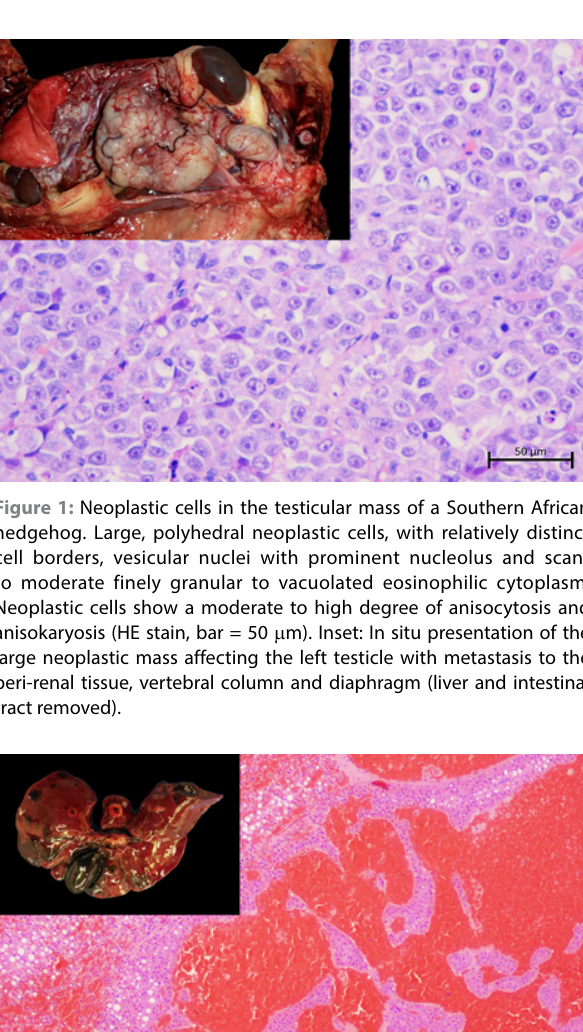
Figure 4: Spermatocytic seminoma. Neoplastic cells showing CD117- positive labelling by IHC (bar = 50 µm). Inset: Neoplastic cells do not stain positive for PAS (bar = 50